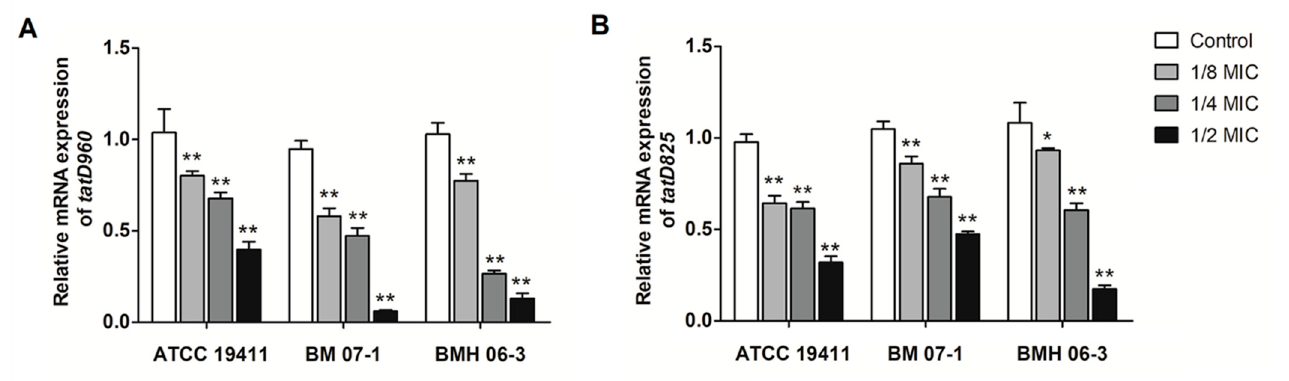
Figure 2. Luteolin exhibited an inhibitory effect on the mRNA expression of tatD genes in T . pyogenes . ( A ) The mRNA expression of tatD960 , ( B ) the mRNA expression of tatD825 . The concentrations of luteolin were 0, 1/8, 1/4, and 1/2 MIC, respectively. Data were presented as means ± SD. (* compared with control, * p < 0.05, ** p < 0.01).